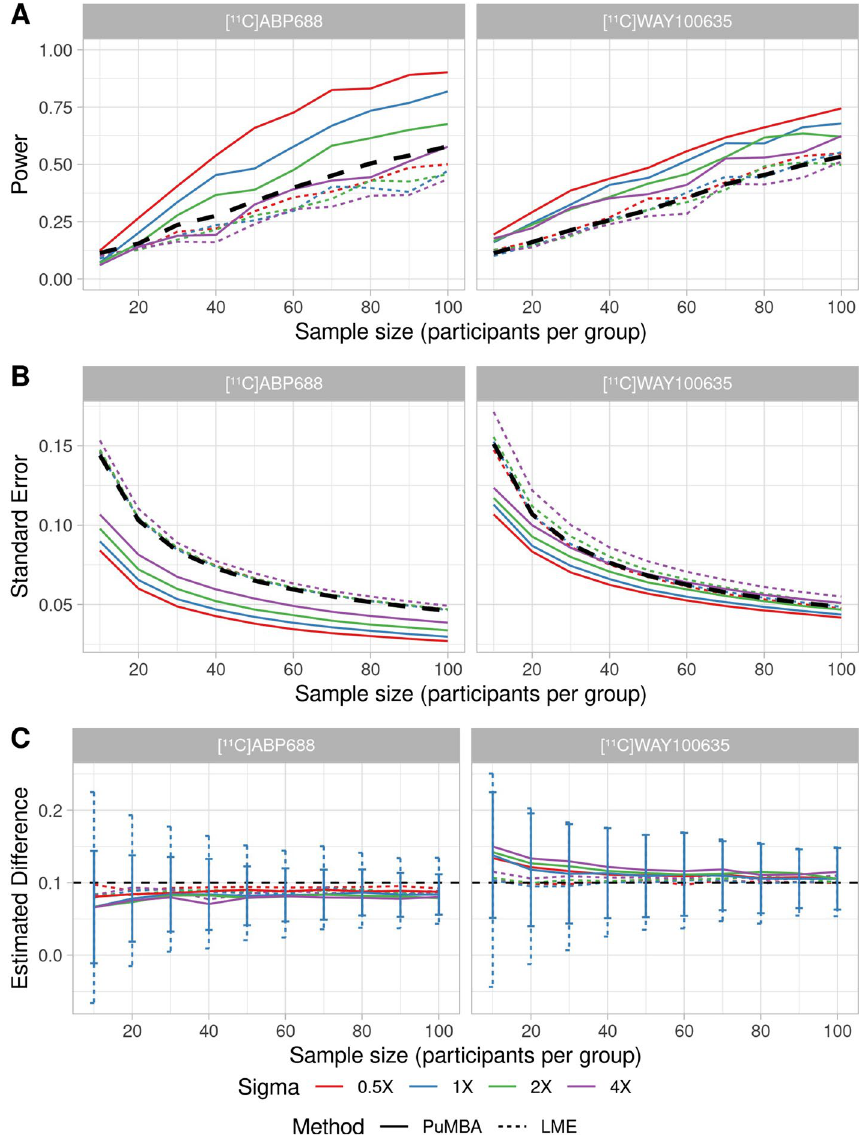
Fig. 4 TACs were simulated with the standard deviation of measurement error equal to the same, half, double or quadruple the estimated measurement error in the original data, represented with colours and modelled with LME or with PuMBA. A Power as a function of sample size for a 0.1 difference between patients and controls. The black dashed line represents the power of the LME analysis applied to the true values of BP P from which the simulations were generated. B Mean standard error of the estimated group differences across the simulated datasets. The black dashed line represents the mean standard error of the LME analysis applied to the true values of BP P . C Mean estimated group differences across simulated datasets, with the true difference of 0.1 shown with a dashed black line. The error bars represent the standard deviation of estimated group differences across simulations, shown only for the original measurement